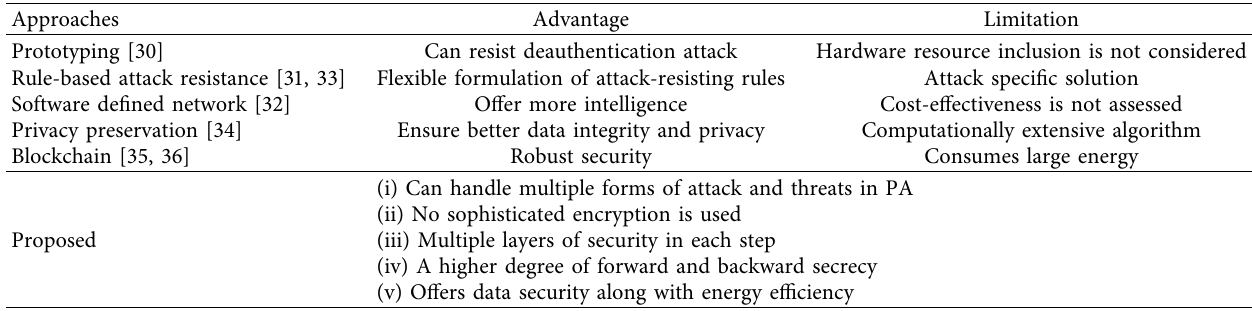
Table 2: Comparison with security